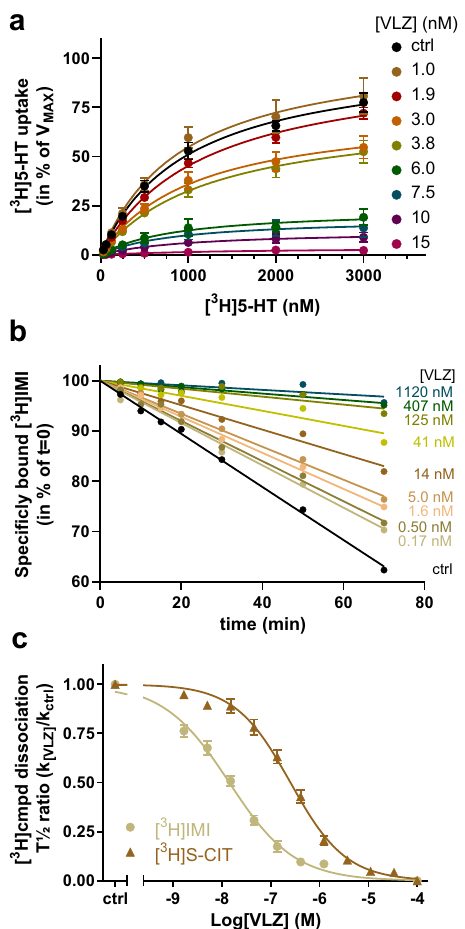
Fig. 2 Indications of VLZ as an allosteric inhibitor of SERT WT. a Saturation uptake experiments for [ 3 H]5-HT transport as a function of increasing VLZ concentrations (0 – 15 nM) are compatible with a non- competitive inhibition for VLZ. Colors of lines and symbols represent various concentrations of VLZ de fi ned in legend. The V MAX for [ 3 H]5- HT decreases with increasing VLZ concentration. Data are shown in percent of 5-HT V MAX in the absence of VLZ ( V MAX in the absence of VLZ is 4899 ± 312 cpm/min/10 5 cells). The K M -value for 5-HT is largely unaffected by increasing VLZ concentrations (Supplementary Table 2).